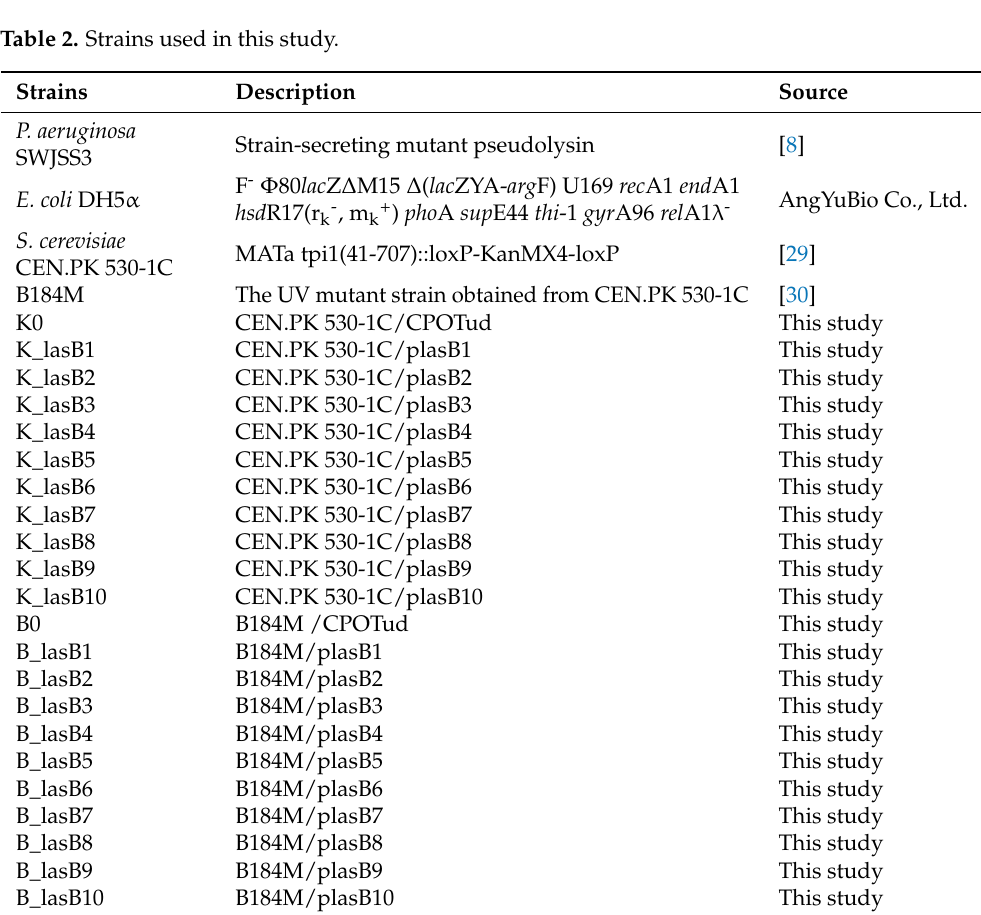
Table 2. Strains used in this